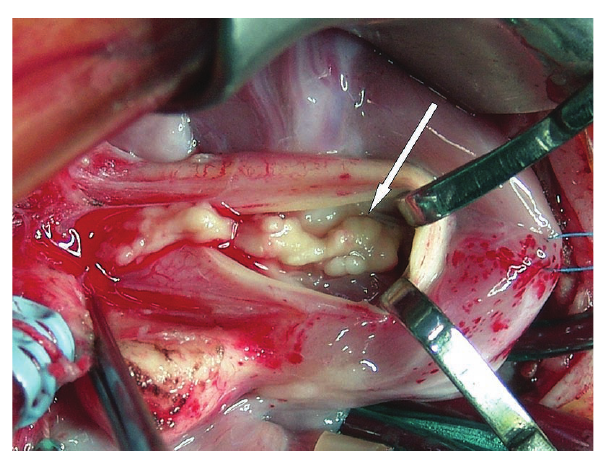
Fig. 2 – Tronco pulmonar aberto longitudinalmente expondo grande vegetação fixada na via de saída do ventrículo direito, estendendo-se até a bifurcação das artérias pulmonares através da valva